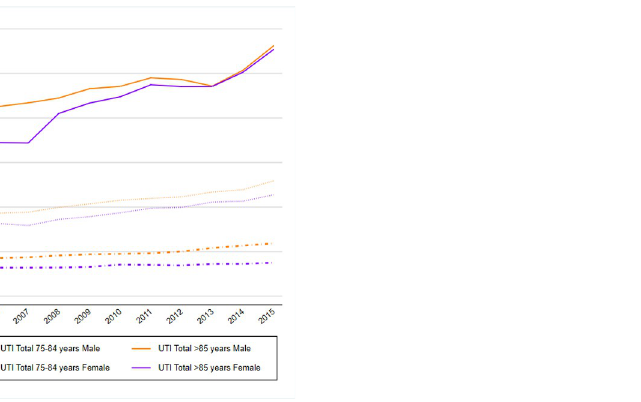
Fig 2. UTIs total. UTIs hospitalization rates by sex and group of age